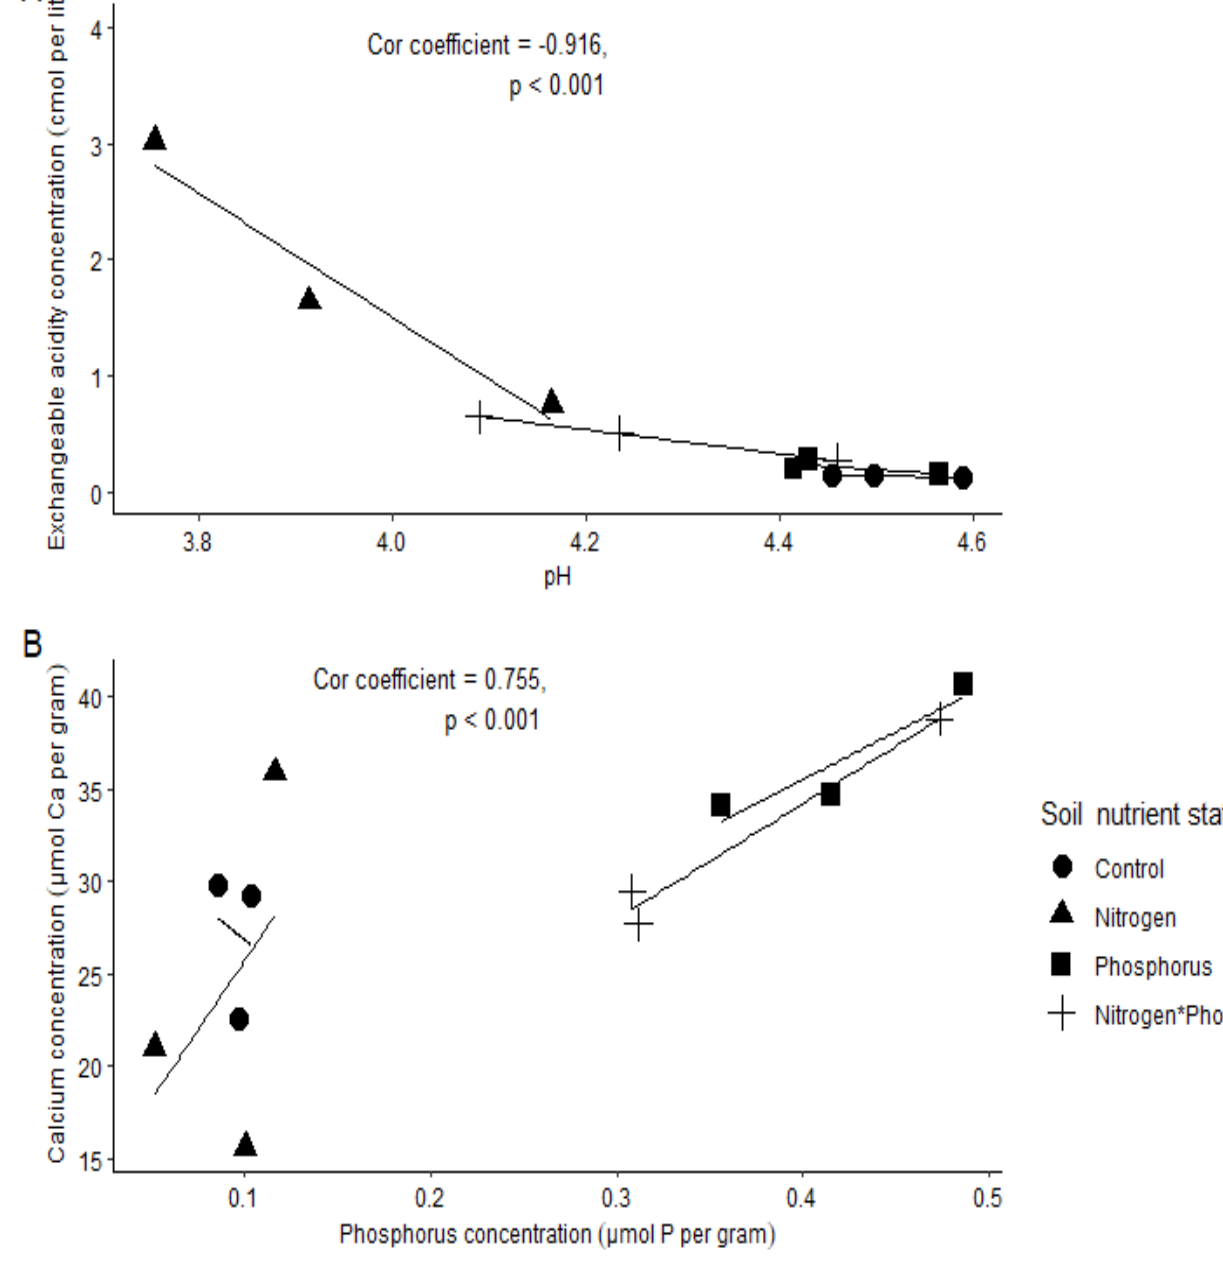
Figure 2. Correlations for soil chemical parameters between ( A ) pH and exchangeable acidity and ( B ) phosphorus and calcium concentrations. Spearman’s correlation coefficient > 0.700 and p < 0.05 is shown here. Key: • = control (no nutrients added); ■ = phosphorus‑enriched soils; ▲ = nitrogen‑enriched soils and ₊ = nitrogen and phosphorus‑enriched soils.